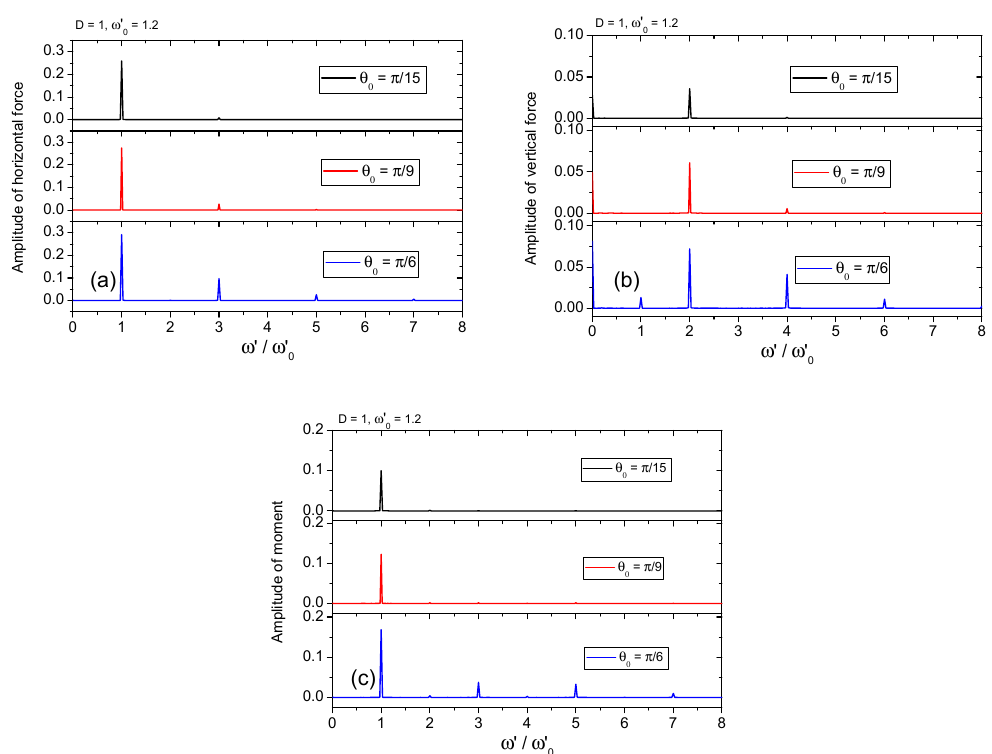
ω′ = : ( a ) FFT analysis